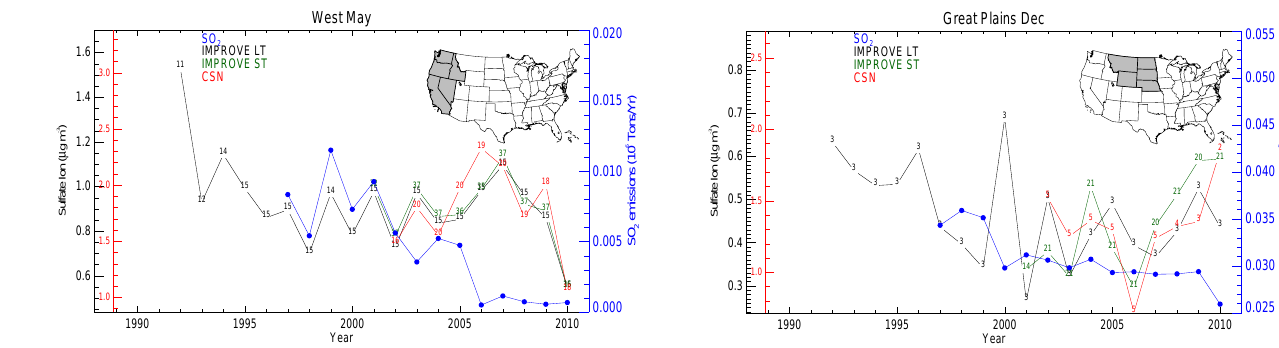
Fig. 9. December monthly mean particulate sulfate ion concentra- tions (µg m − 3 ) for the Great Plains region (see gray states on in- set map) from long-term (LT) and short-term (ST) IMPROVE sites (left black axis) and CSN sites (left red axis), and power plant SO 2 emissions (million t yr − 1 ) (right blue axis). The number of com- plete sites with valid data available for a given year is used as the plot symbol for each time